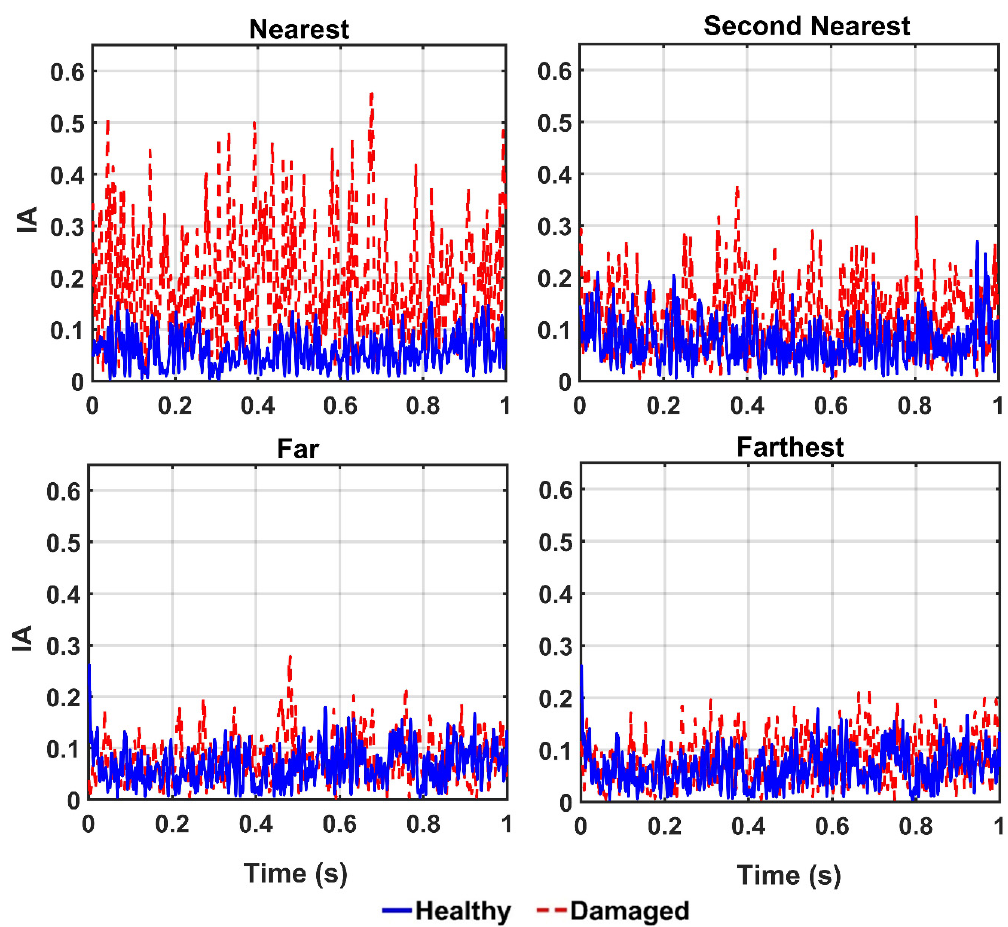
Figure 14. The IA output of the IMFs for di ff erent locations from the damaged element by the proposed model.